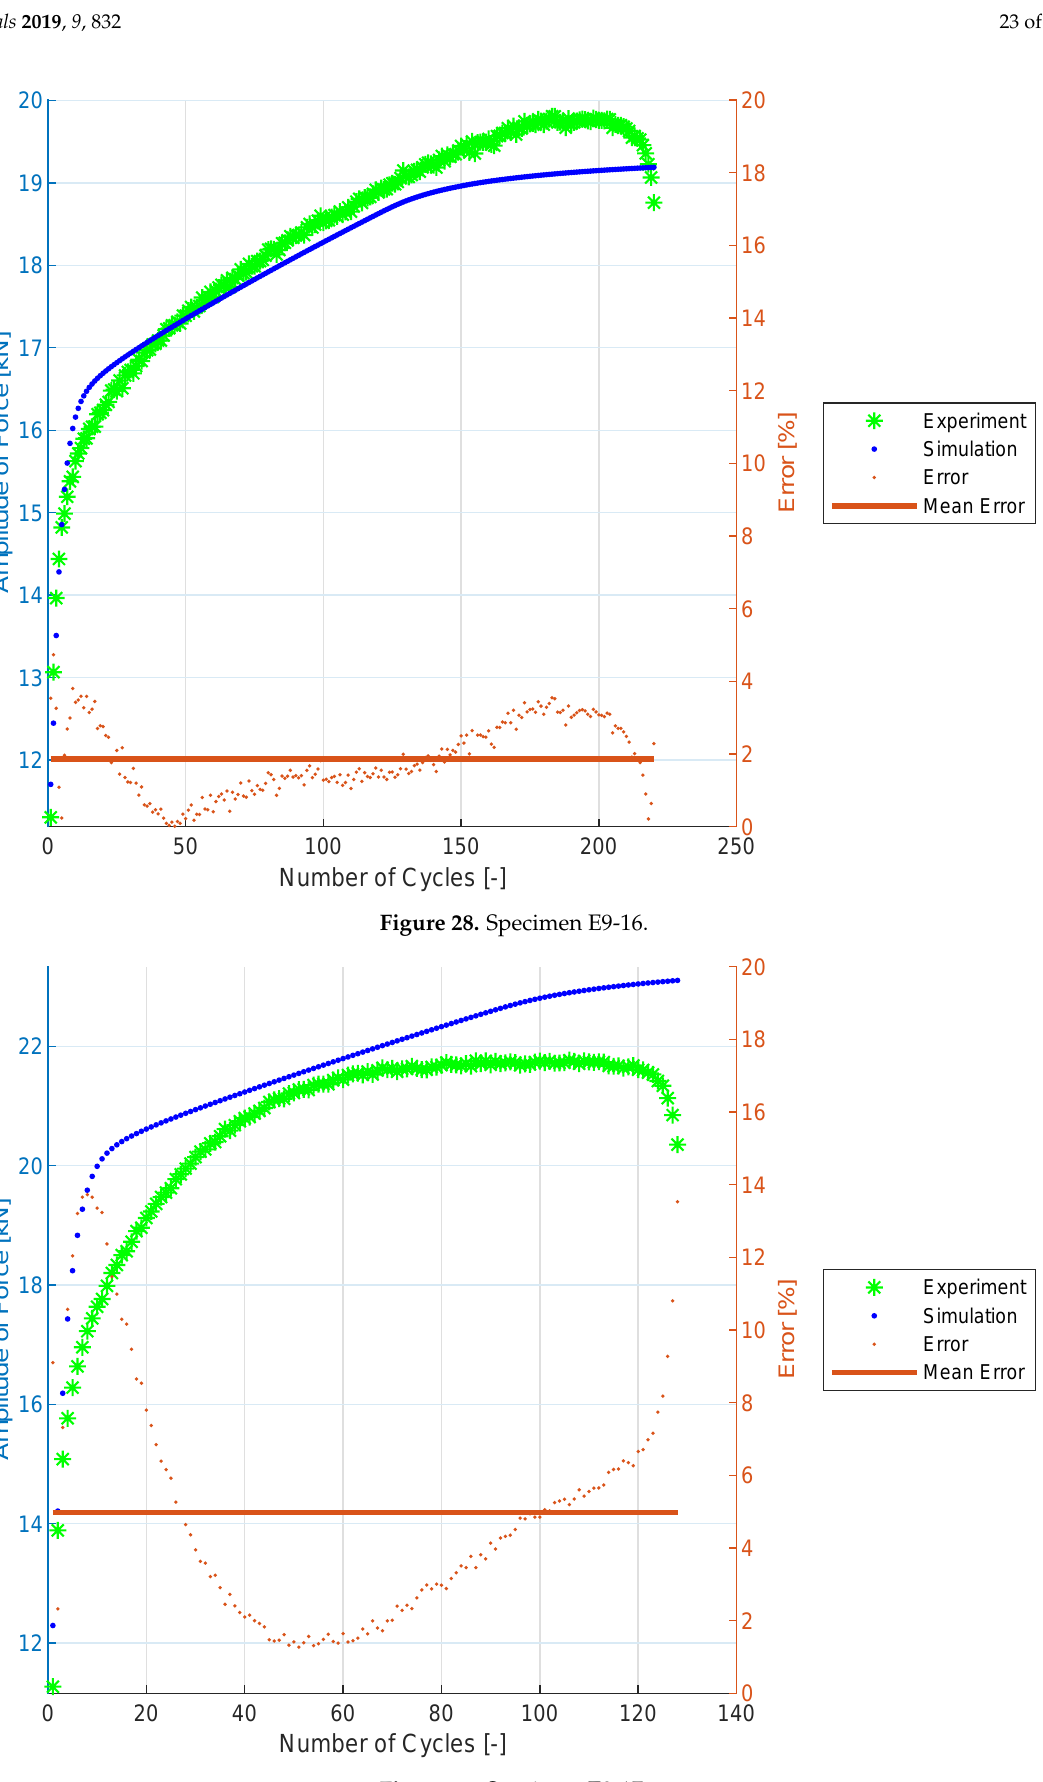
Figure 29. Specimen